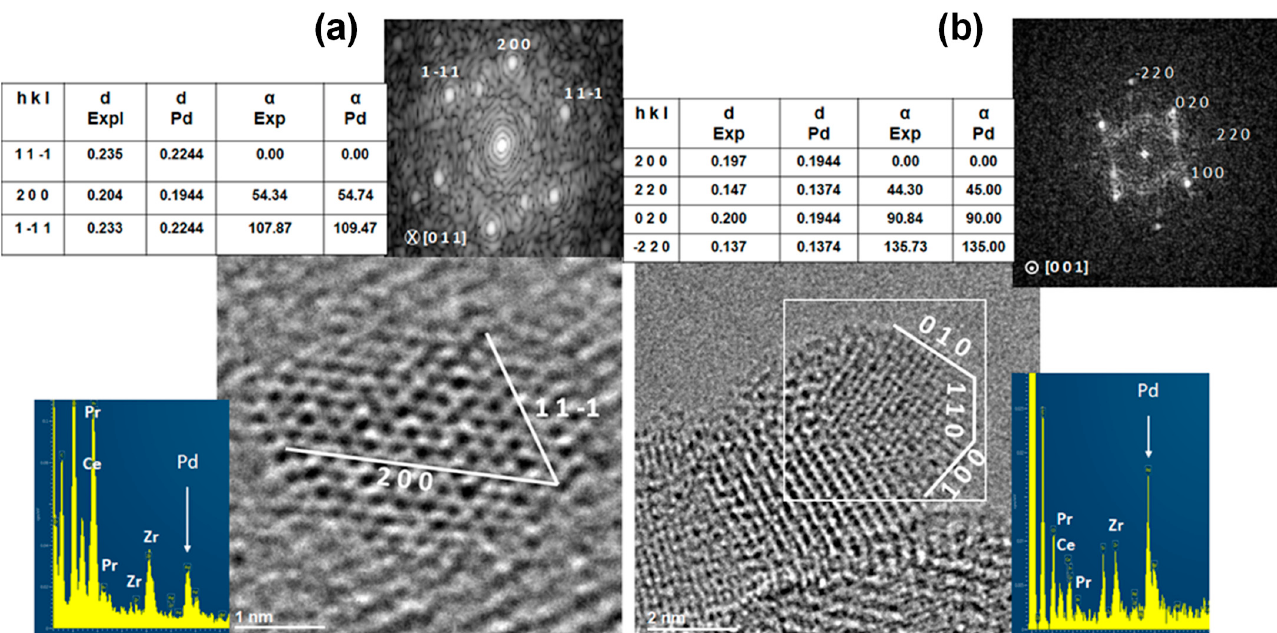
Figure 2. Representative HAADF-STEM micrographs of Pd clusters observed on Pd-HS after a reduction step at 500 °C for 1 h in ( a ) 100 vol% H 2 and ( b ) 1 vol% CO/He. The insets are the corresponding FFT (fast Fourier transform) patterns and EDX spectra.